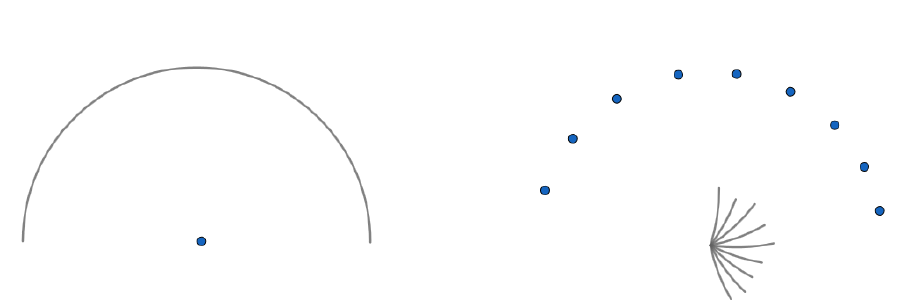
Figure 1: Operation on unit circular